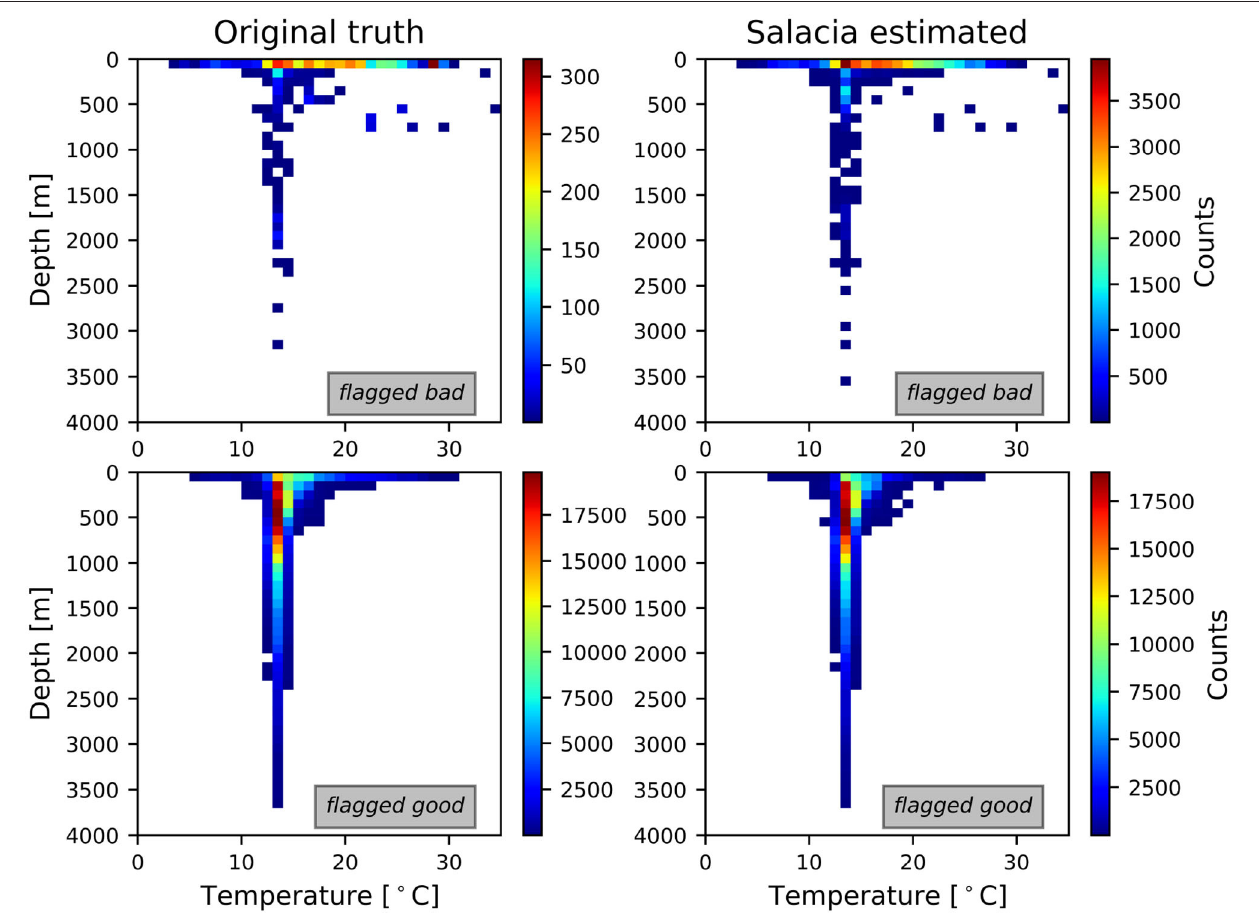
FIGURE 4 | SalaciaML results: (top left) the original bad flagged samples; (top right) the estimated bad samples; (bottom left) the original good samples; (bottom right) the estimated good . The color scale indicates the density of the overlapping samples.